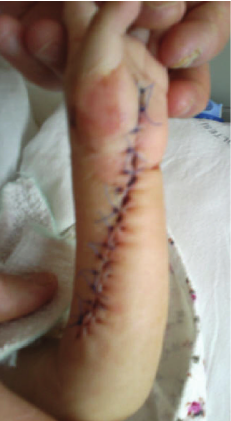
Figure 3: Postoperative view of the patient’s forearm at the second week of